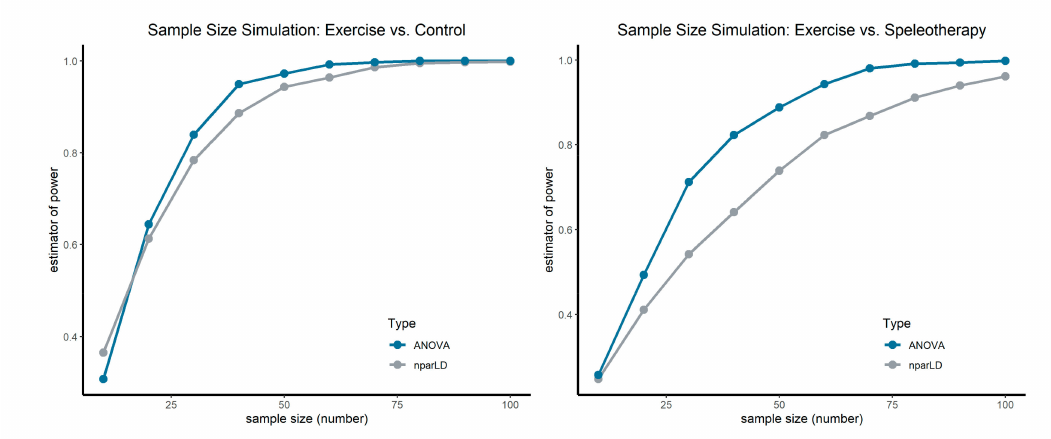
Figure 6. Sample size simulation for the primary outcome FeNO. Left graph shows the comparison of the exercise group vs. the control group. Right graph shows the comparison of the exercise and speleotherapy group. Sample size simulation was performed for nparLD and